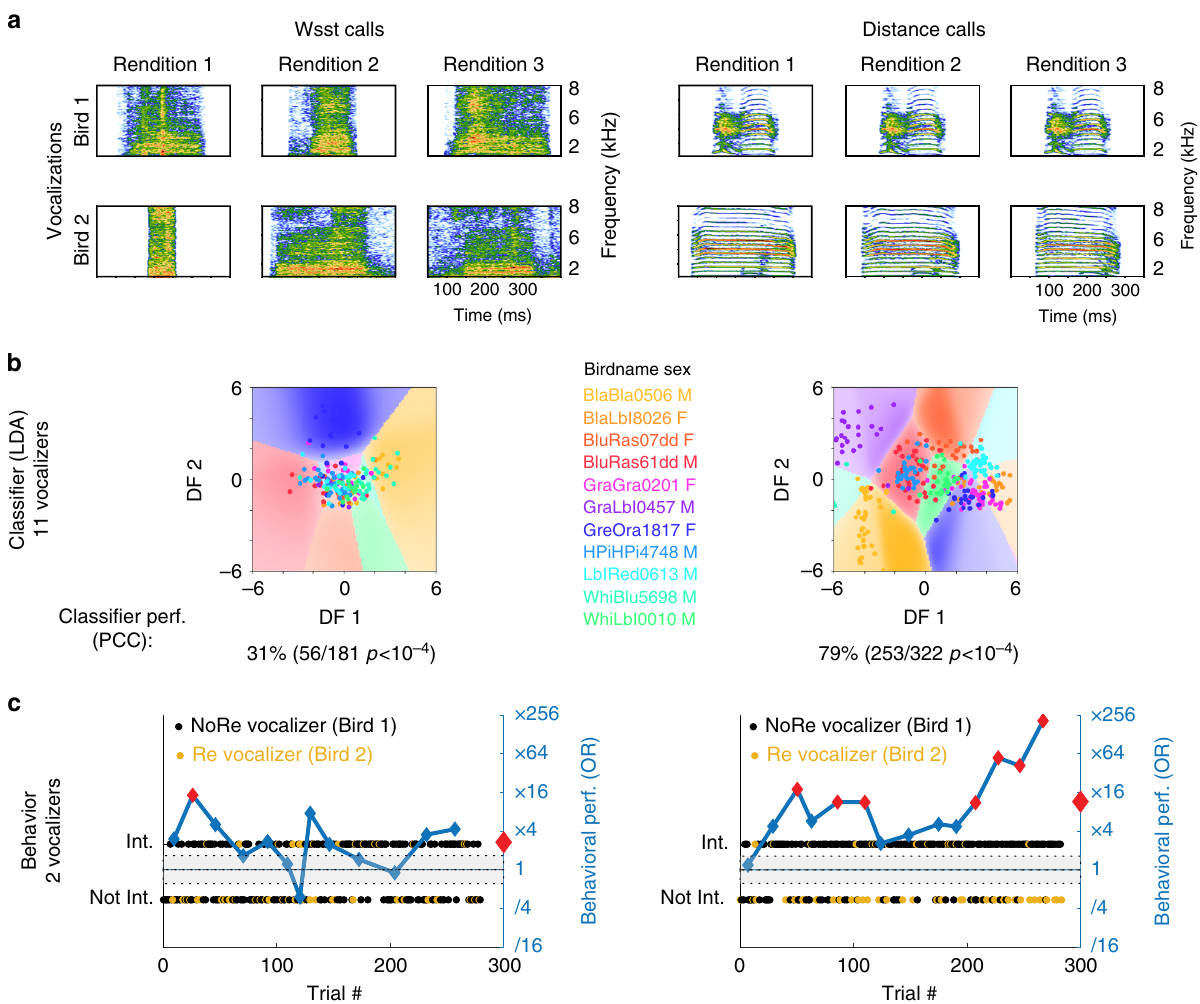
Fig. 3 Vocalizer discrimination for two call types. Vocalizations ( a ): Spectrograms of aggressive calls (Ws, Supplementary Audio 1) and contact Distance calls (DC, Supplementary Audio 2) from two different males. Regularized linear discriminant analysis (LDA, b ): LDA was performed on acoustic features to classify calls (each dot corresponds to a call rendition) along the same 11 vocalizers for Ws ( n = 181) and DC ( n = 322). Cross-validated classi fi er performance is shown as Percent of Correct Classi fi cation (PCC; chance level, 9.1%). Behavior ( c ): The behavioral performance of one subject for discriminating Bird1 vs. Bird2 is shown for Ws (35 and 31 renditions) and DC (29 and 33 renditions). Each dot corresponds to a stimulus (i.e. a sequence of calls). The behavioral performance as measured by the odds ratio (OR, see Fig. 1) is given by the blue line. Red diamonds indicate an OR value signi fi cantly different from 1. The gray area depicts the 5 − 95% quantiles for a random odds ratio for all